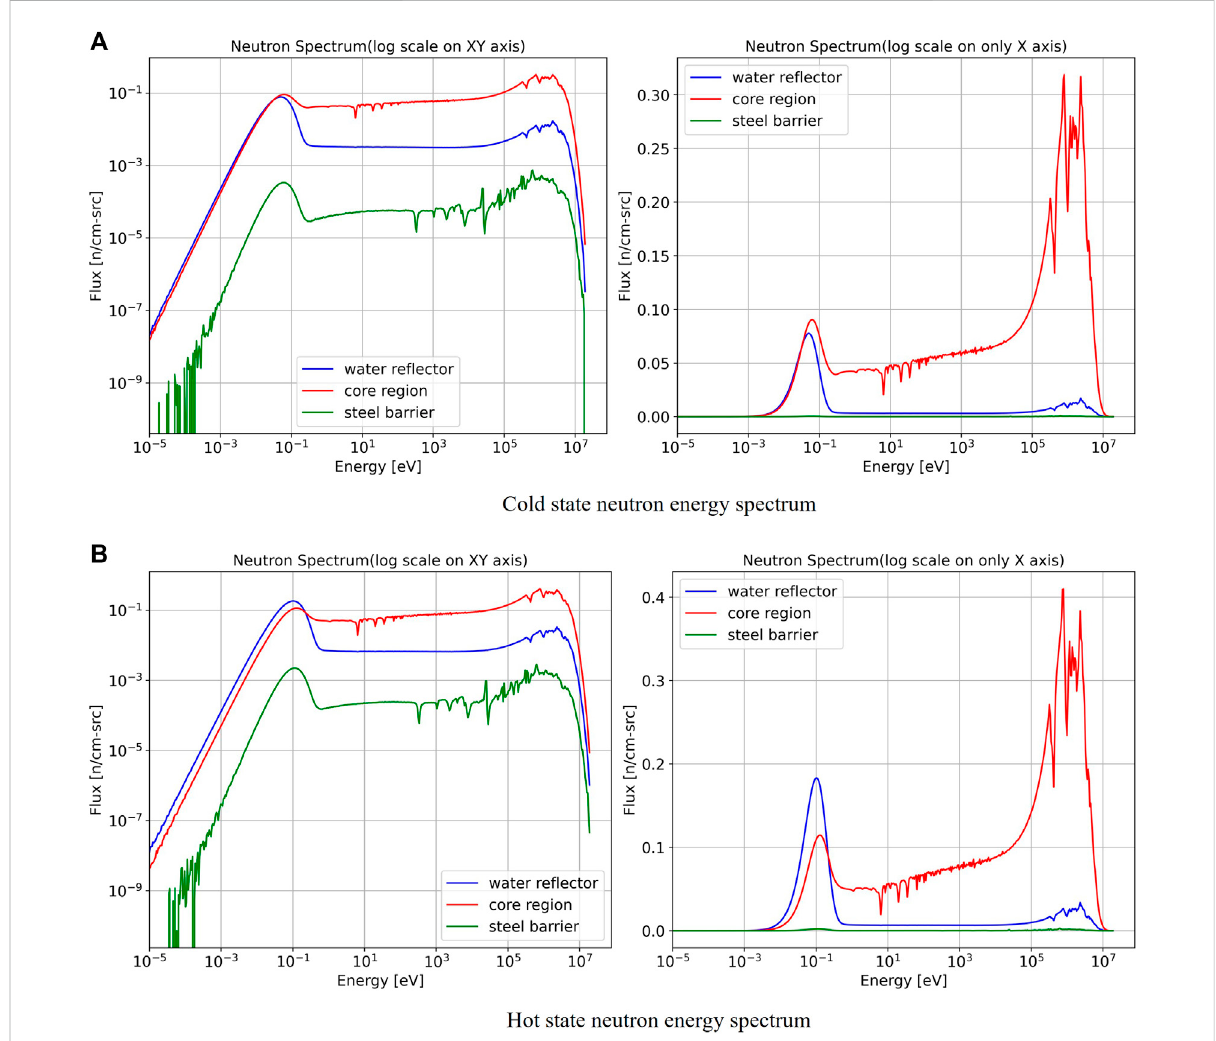
FIGURE 8 The steel barrier, re fl ector, and core ’ s neutron energy spectrums in the (A) cold and (B) hot